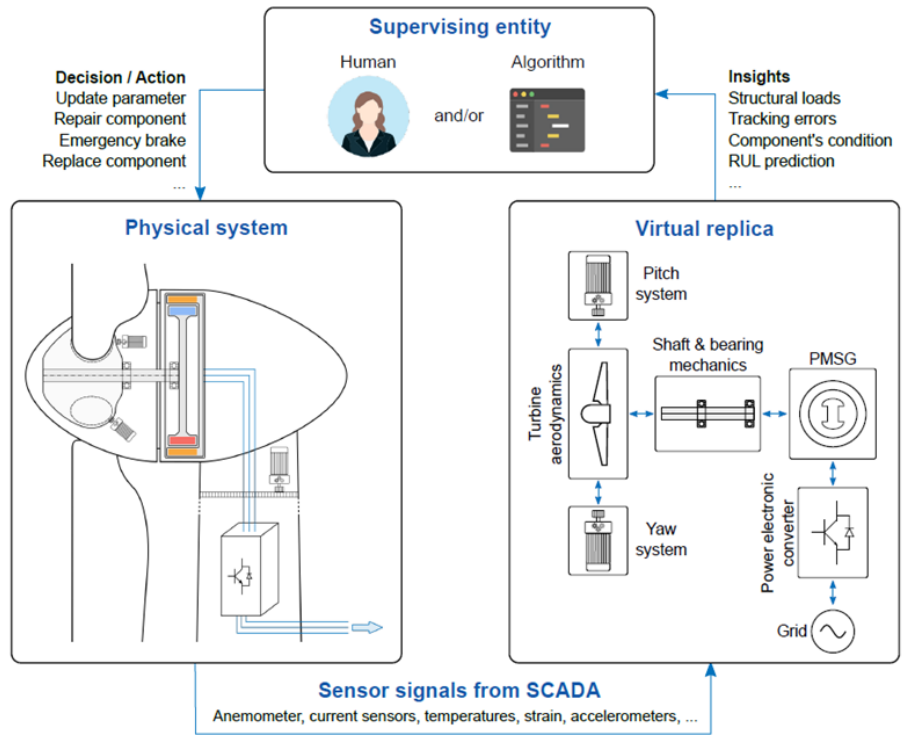
Figure 21. Digital twin schematic of a wind turbine, including the physical system ( left ), its virtual replica ( right ) and the supervising entity ( top ) [60].